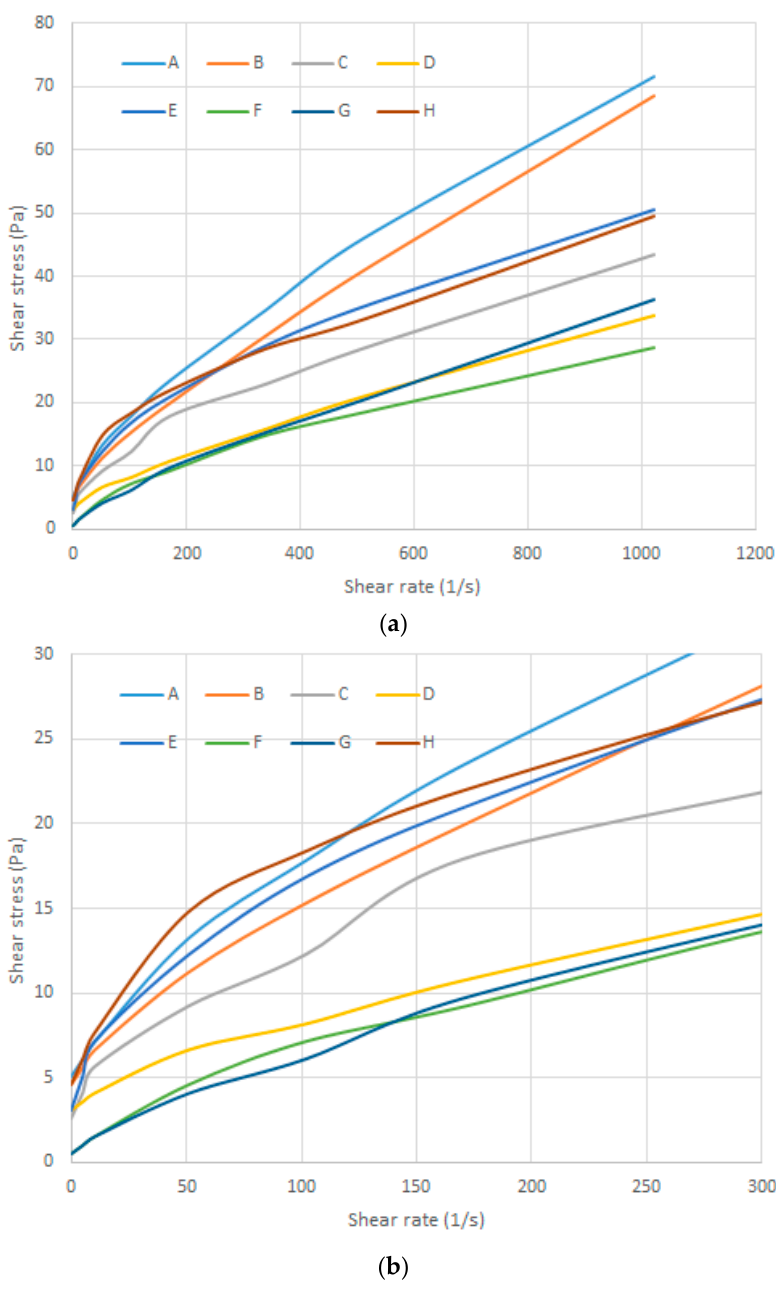
Figure 2. Flow curves of eight drilling fluids. ( a ) Upper figure—Full shear rate range; ( b ) Lower figure—Relevant shear rates.